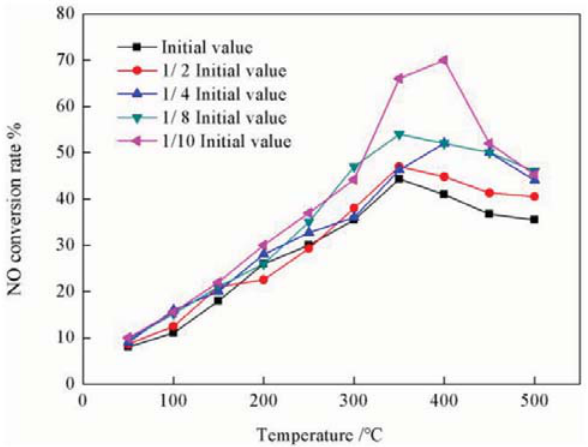
Figure 8: Comparison the denitrification rate for different acid